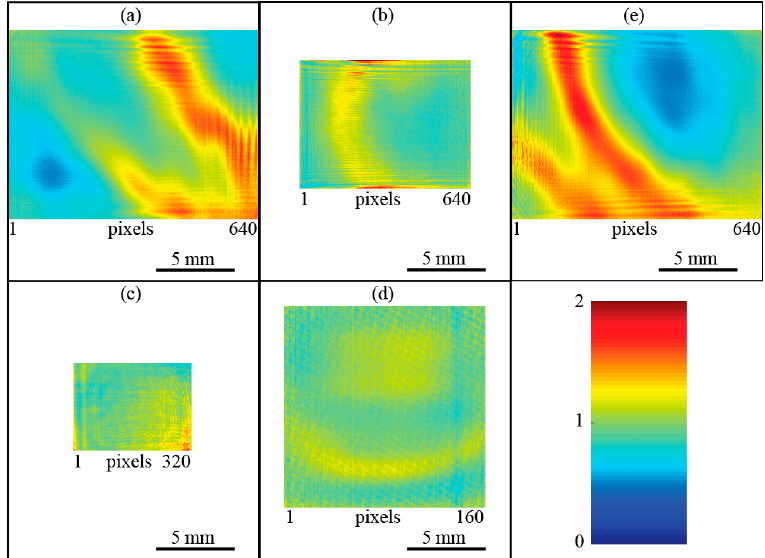
Figure 4. Relative camera response across the entire image area at λ = 118.8 μ m ( a – d ). A value of one corresponds to the average response of the image area. ( a ) Cam1; ( b ) Cam2; ( c ) Cam3; ( d ) Cam4; ( e ) Cam1 at λ = 96.5 μ m.